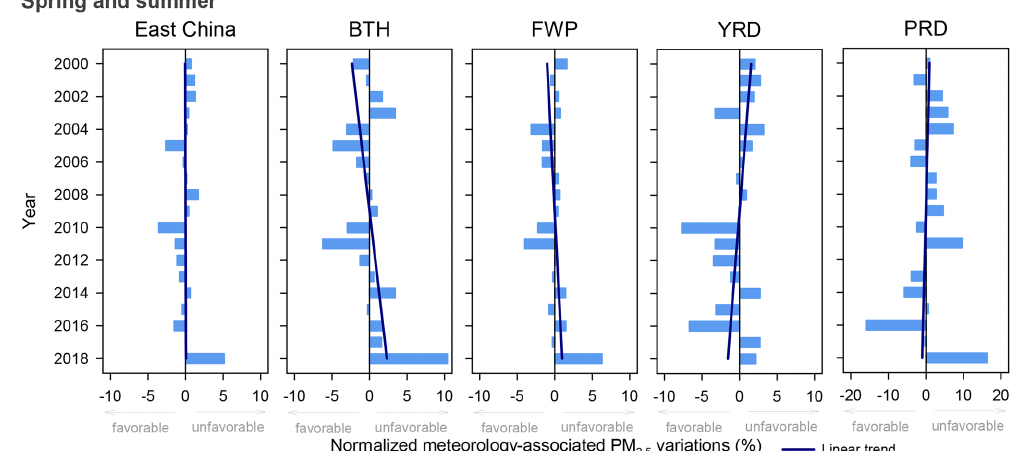
Figure 5. The GAM-estimated relative impact of meteorology on annual average PM 2 . 5 (top row), relative impact of meteorology on average PM 2 . 5 in fall–winter (September, October, November, December, January in next year, and February in next year) (middle), and relative impact of meteorology on average PM 2 . 5 in spring–summer (bottom row) with the long-term trends estimated by polynomial and linear regressions over eastern China, BTH, FWP, YRD, and